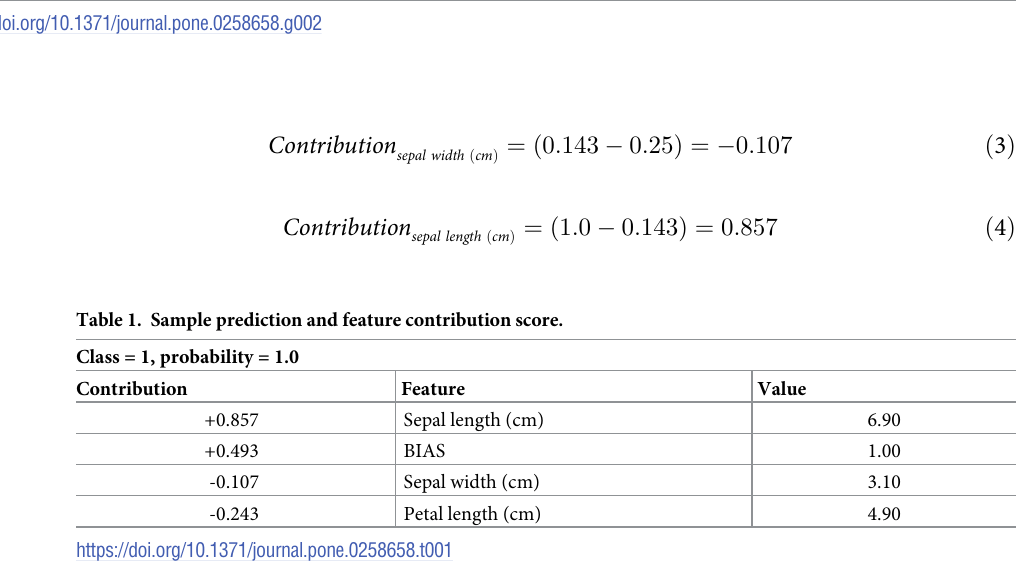
Fig 2. Single decision tree linearized using the eli5 package. By employing a general linear equation to define the relative contributions of each feature as decisions are made at an increasing depth in the tree, it is possible to derive feature importance values which lead to a positive (Iris Virginica) or negative (Iris versicolor) classification. This analysis offers a unique advantage over Gini importance, partial dependence, and permutation importance such that feature importance coefficients provide both a directionality and magnitude for each feature in delineating data into the positive and negative classes.